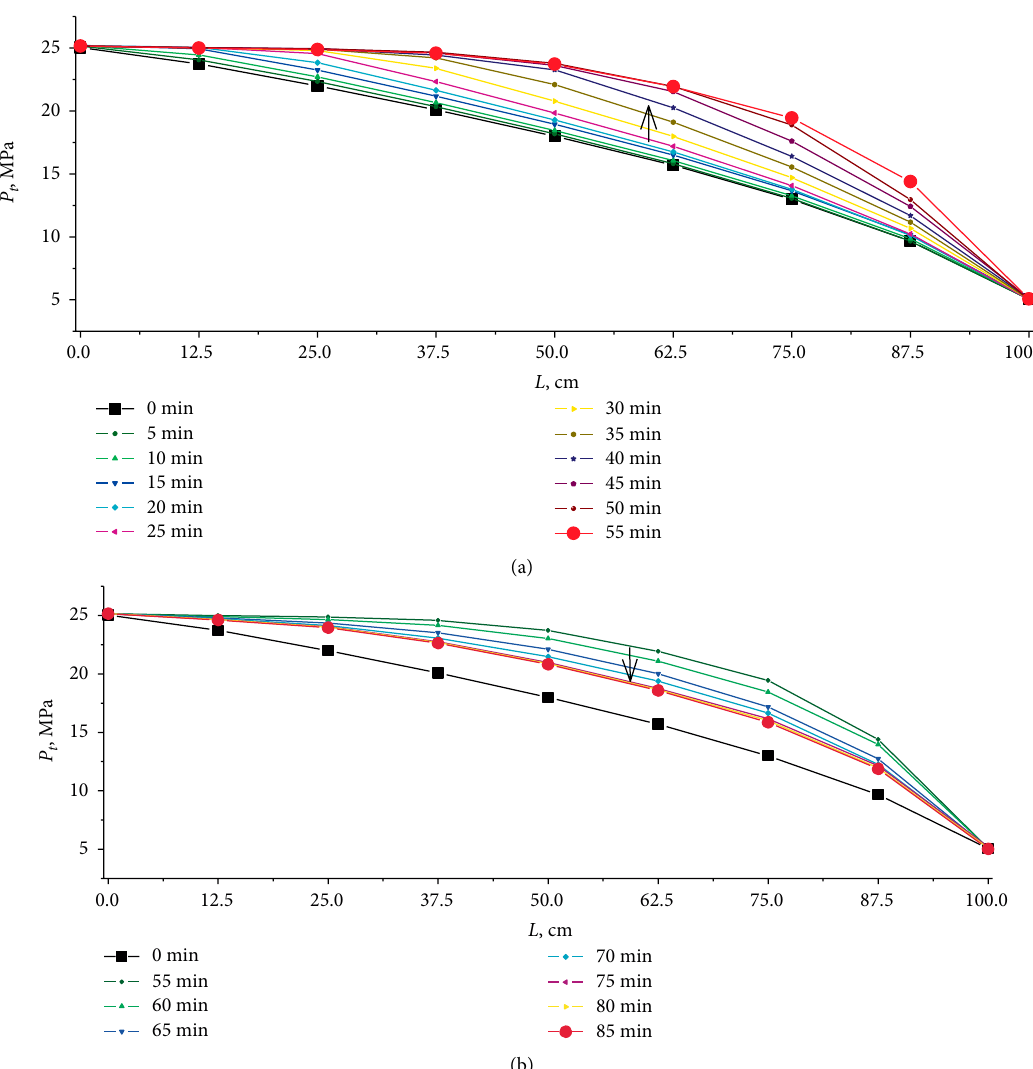
flooding: (a) 0–55 min and (b) 55–85 min. 2